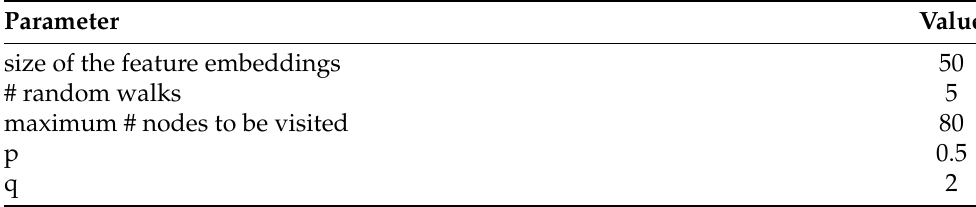
Table 3. Hyperparameters of Node2Vec model.